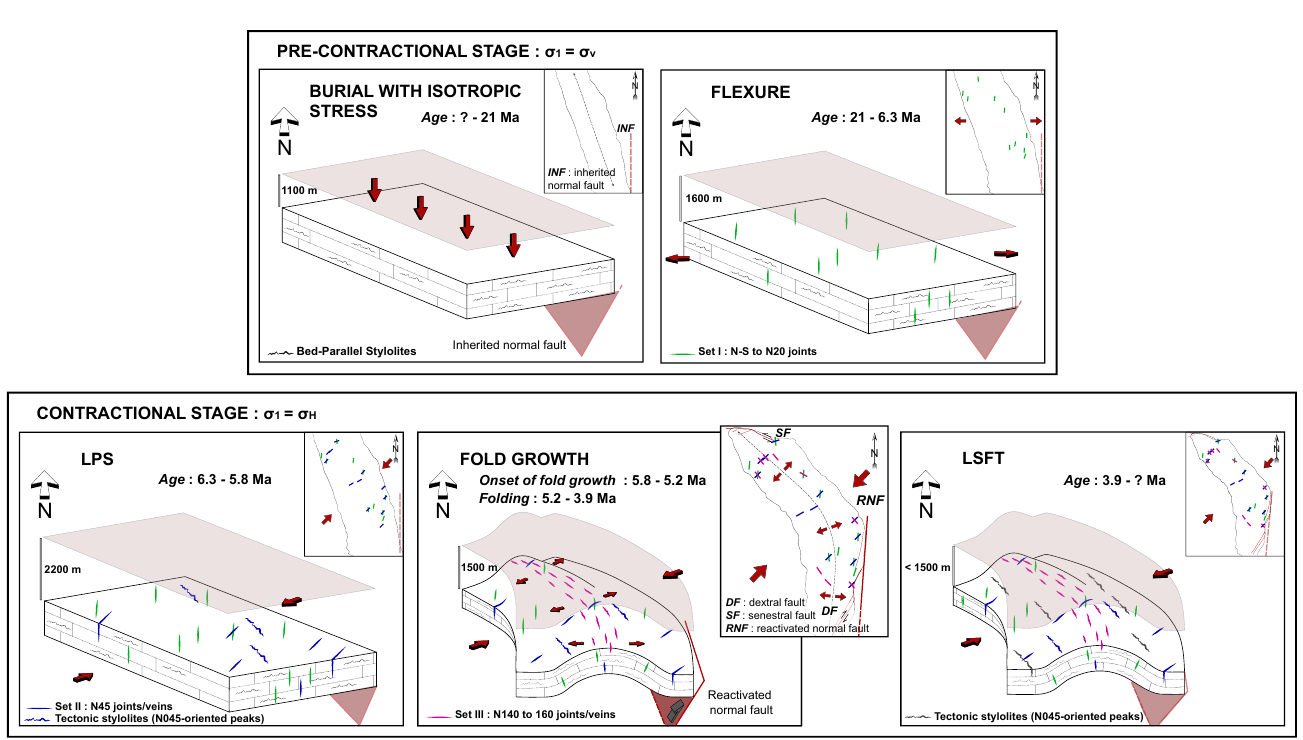
Figure 8. Interpretative model of the history of deformation in the Cingoli Anticline. The structural evolution of the area is represented in 3D and in map view. For each stage of deformation, the main principal stress σ 1 is represented as red arrows, as well as the associated mesostructures (green: set I, blue: set II, pink: set III) and burial depths recorded by the Scaglia Rossa (deduced from burial curves). Faults are represented by red lines in map view, dotted lines when inactive, and solid lines when active. The inherited normal fault is also represented on the 3D block, by a red plane in transparency when it is